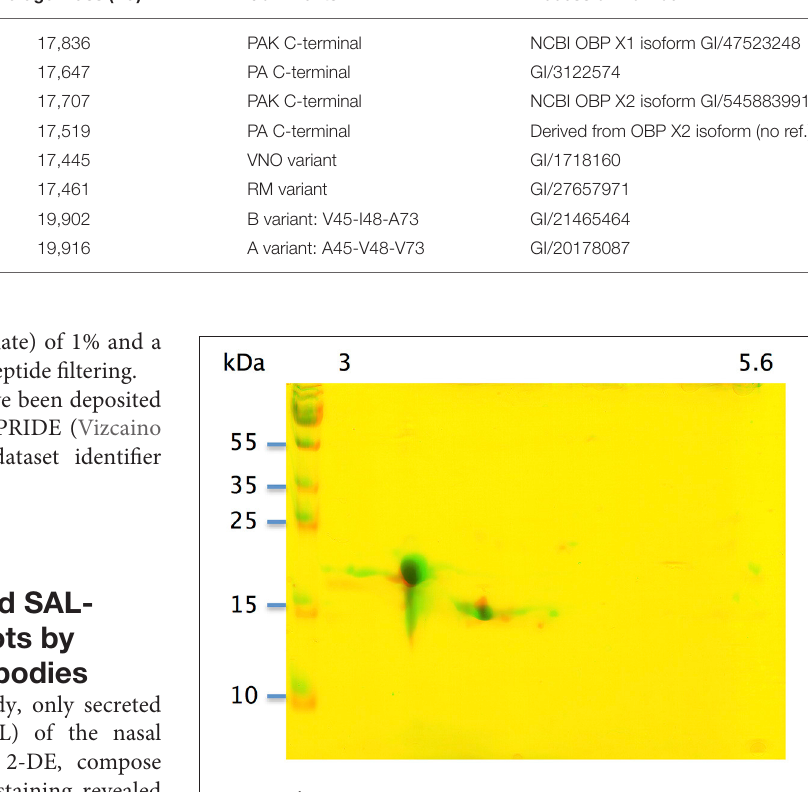
FIGURE 1 | Two-dimensional electrophoresis of soluble proteins extracted from two pubertal male pigs M14 and M39. Merge of Coomassie-blue staining of M14 and M39 secretomes obtained by 2-DE. X-axis: pI, Y-axis: molecular